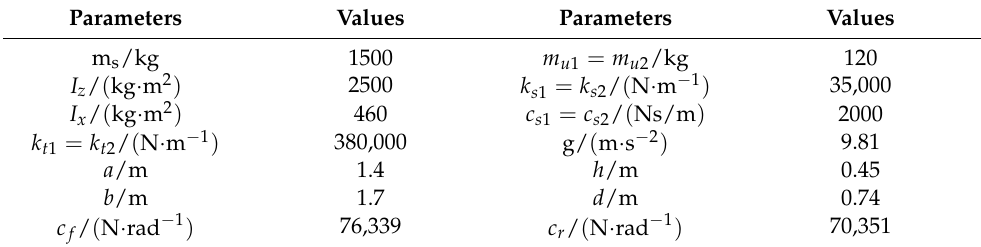
Table 1. Parameters of the vehicle